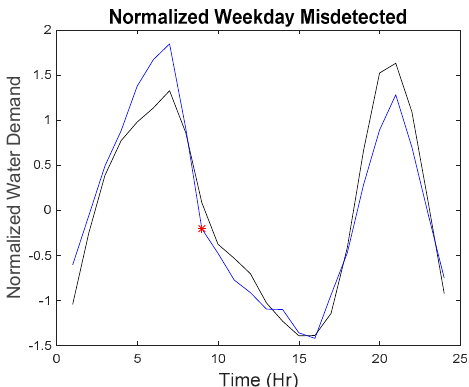
Figure 15. Shape of series with first missed detected anomaly.